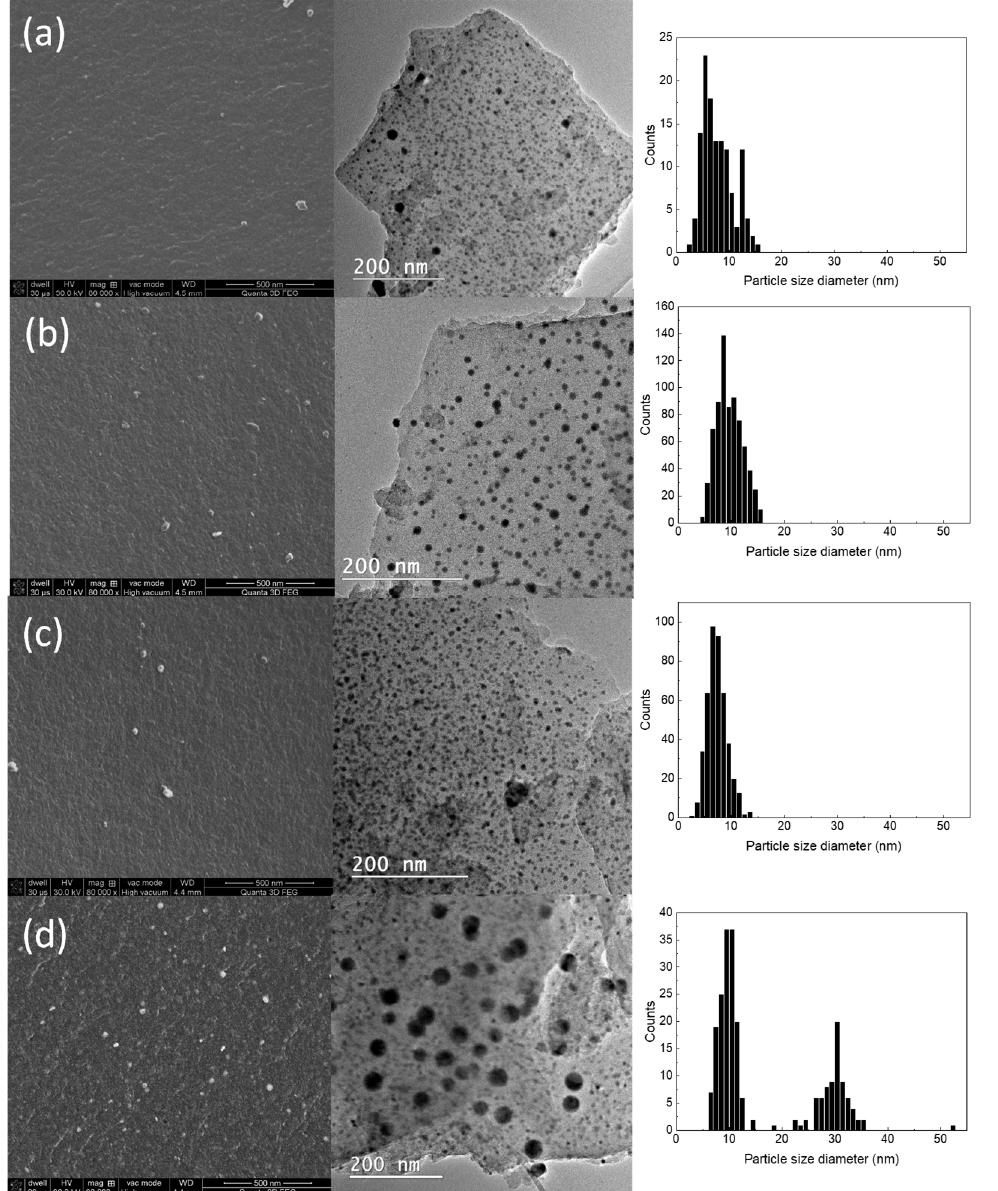
Figure 2. SEM and TEM images together with nanoparticle size histograms corresponding to samples ( a ) CXBiFe 0 , ( b ) CXBiFe 0.01 , ( c ) CXBiFe 0.12 and ( d ) CXBiFe 1.2 .